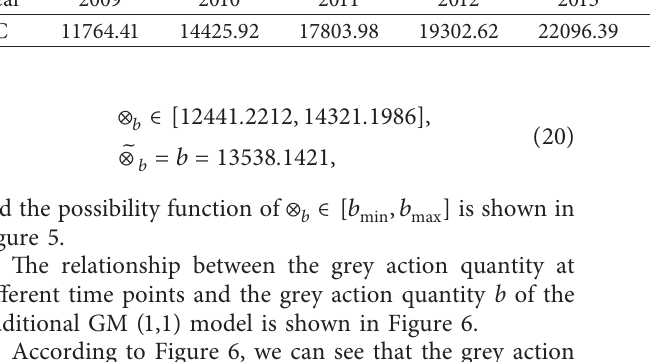
Figure 5: The possibility function of ⊗